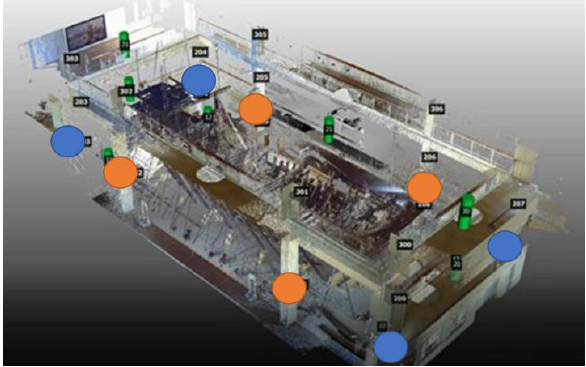
Figure 10. Ground control points for photogrammetric datum definition arranged in large volume